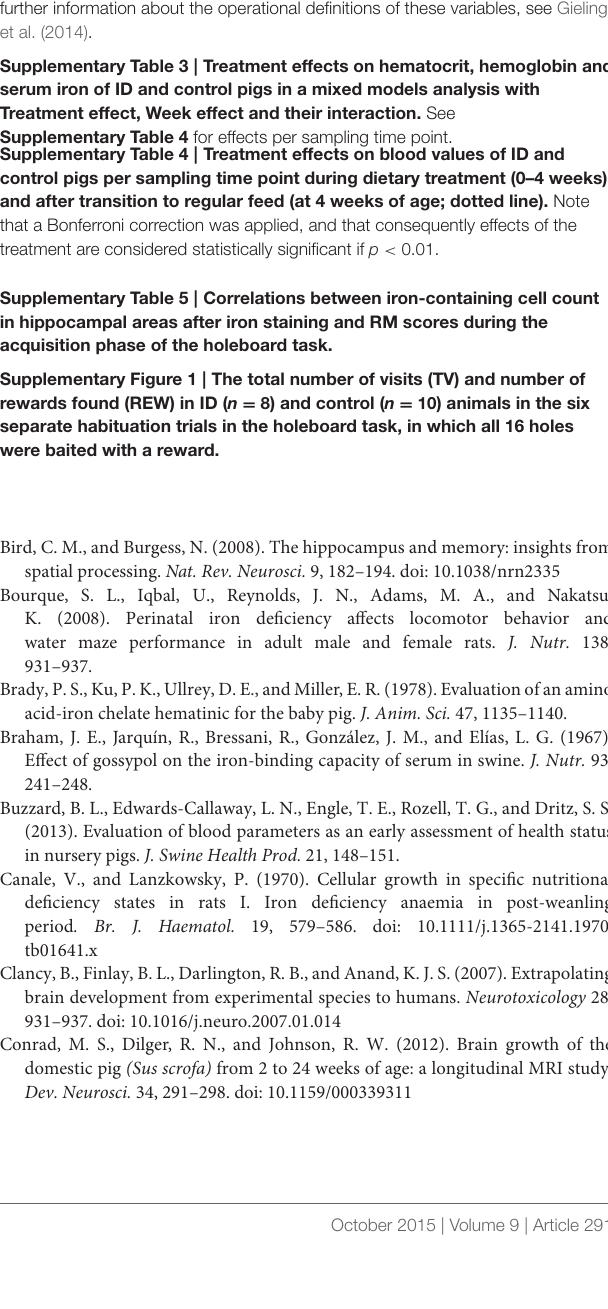
Supplementary Table 1 | Number of observations per blood collection for blood value